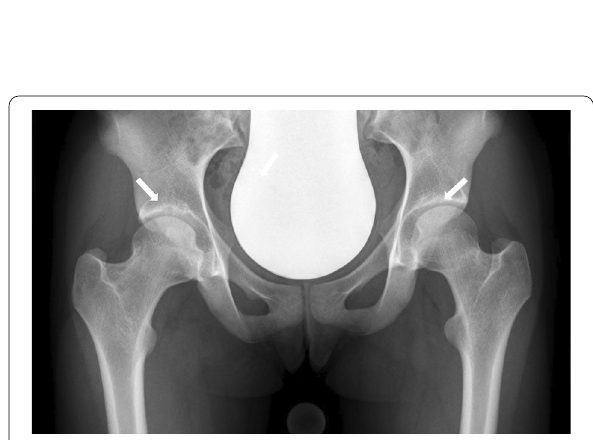
Fig. 6 Radiograph of a 17-years-old female participant with SAF on both sides (white